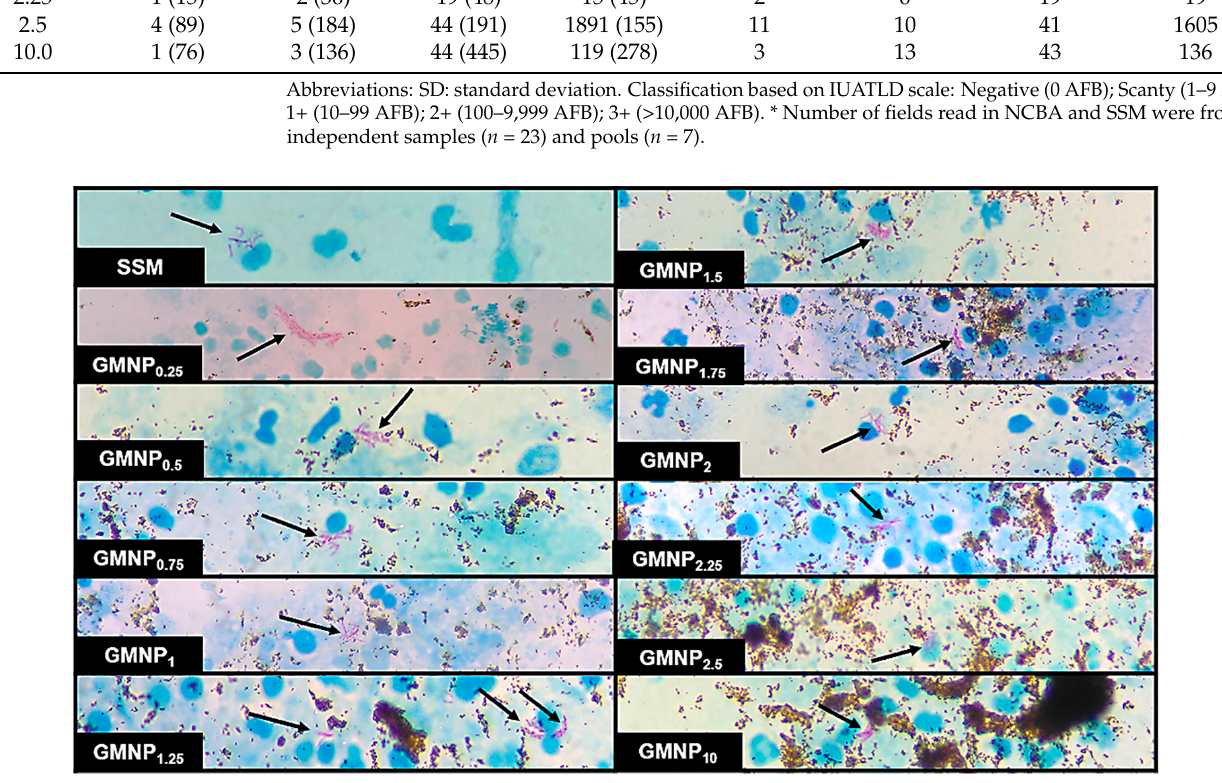
Figure 3. Micrographs of a positive TB sample analyzed by SSM and NCBA showing clustered purple-magenta bacilli (indicated by arrows) and GMNP in brown. Subscripts indicate the concentration of GMNP used.